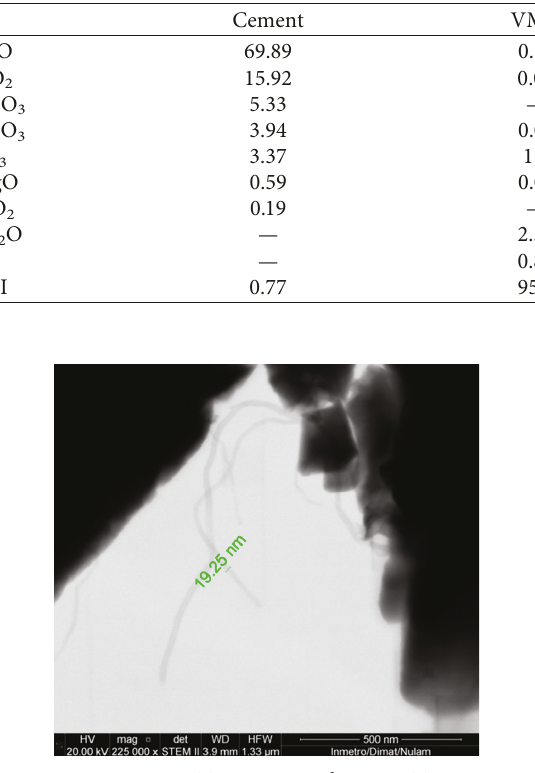
Figure 7: TEM image of